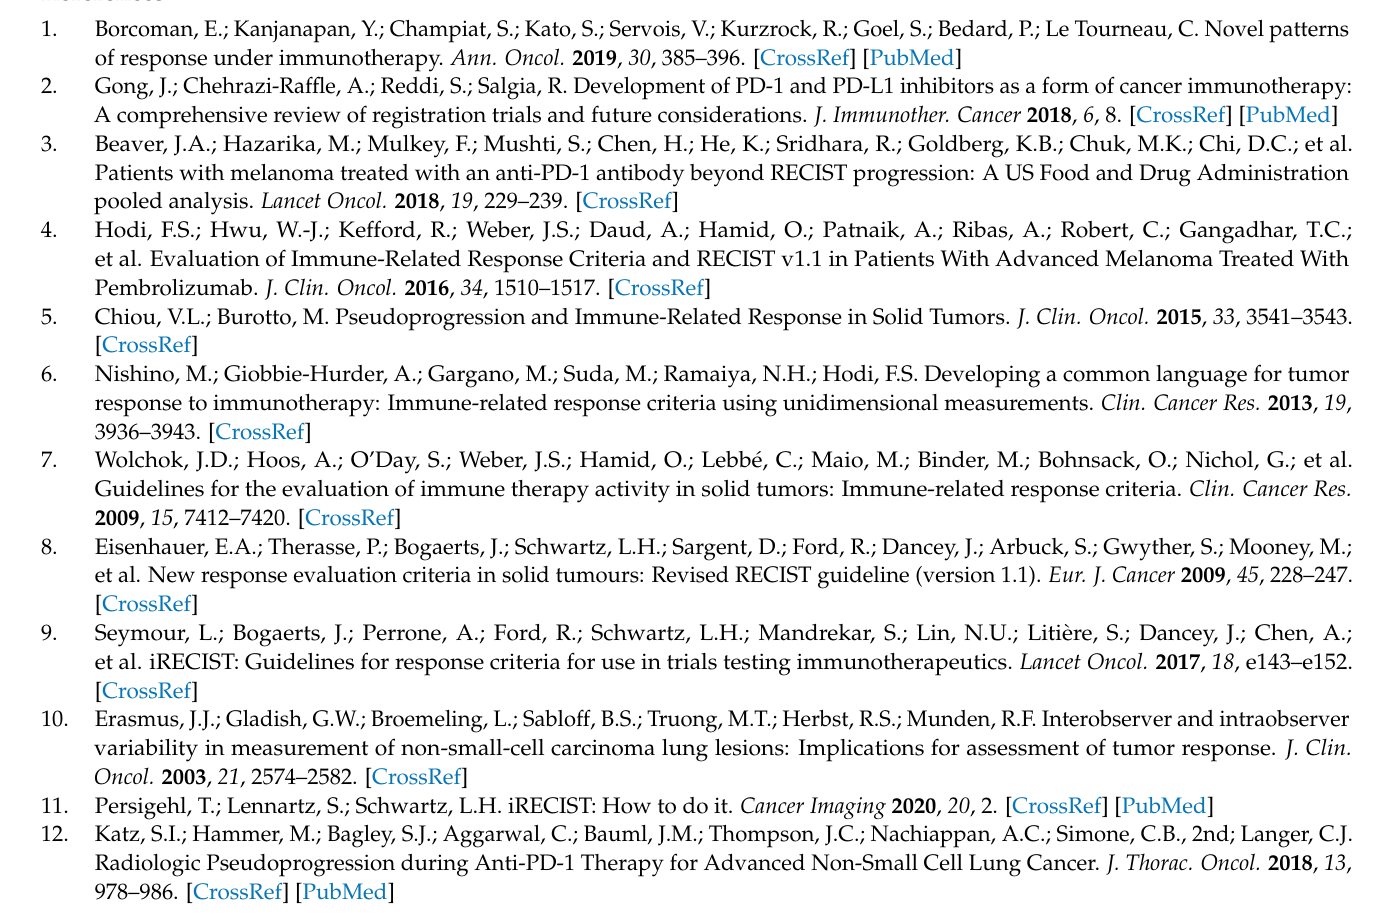
Supplementary Materials: The following are available online at https://www.mdpi.com/2072-669 4/13/1/120/s1, Figure S1: Risk of bias quality assessment for one randomized controlled clinical trial, Figure S2: Forest plots showing the pooled estimates of ORR and iORR, Figure S3: Forest plots showing the pooled estimates of DCR and iDCR, Figure S4: Funnel plots for visual appraisal of literature bias, Table S1: The Newcastle-Ottawa scale quality assessment for non-randomized studies, Table S2: Detailed search